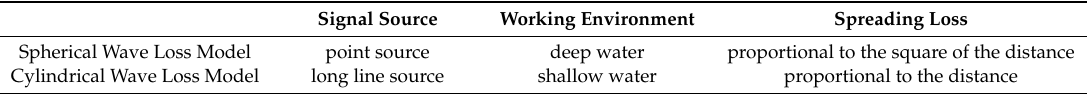
Table 2. Acoustic wave loss